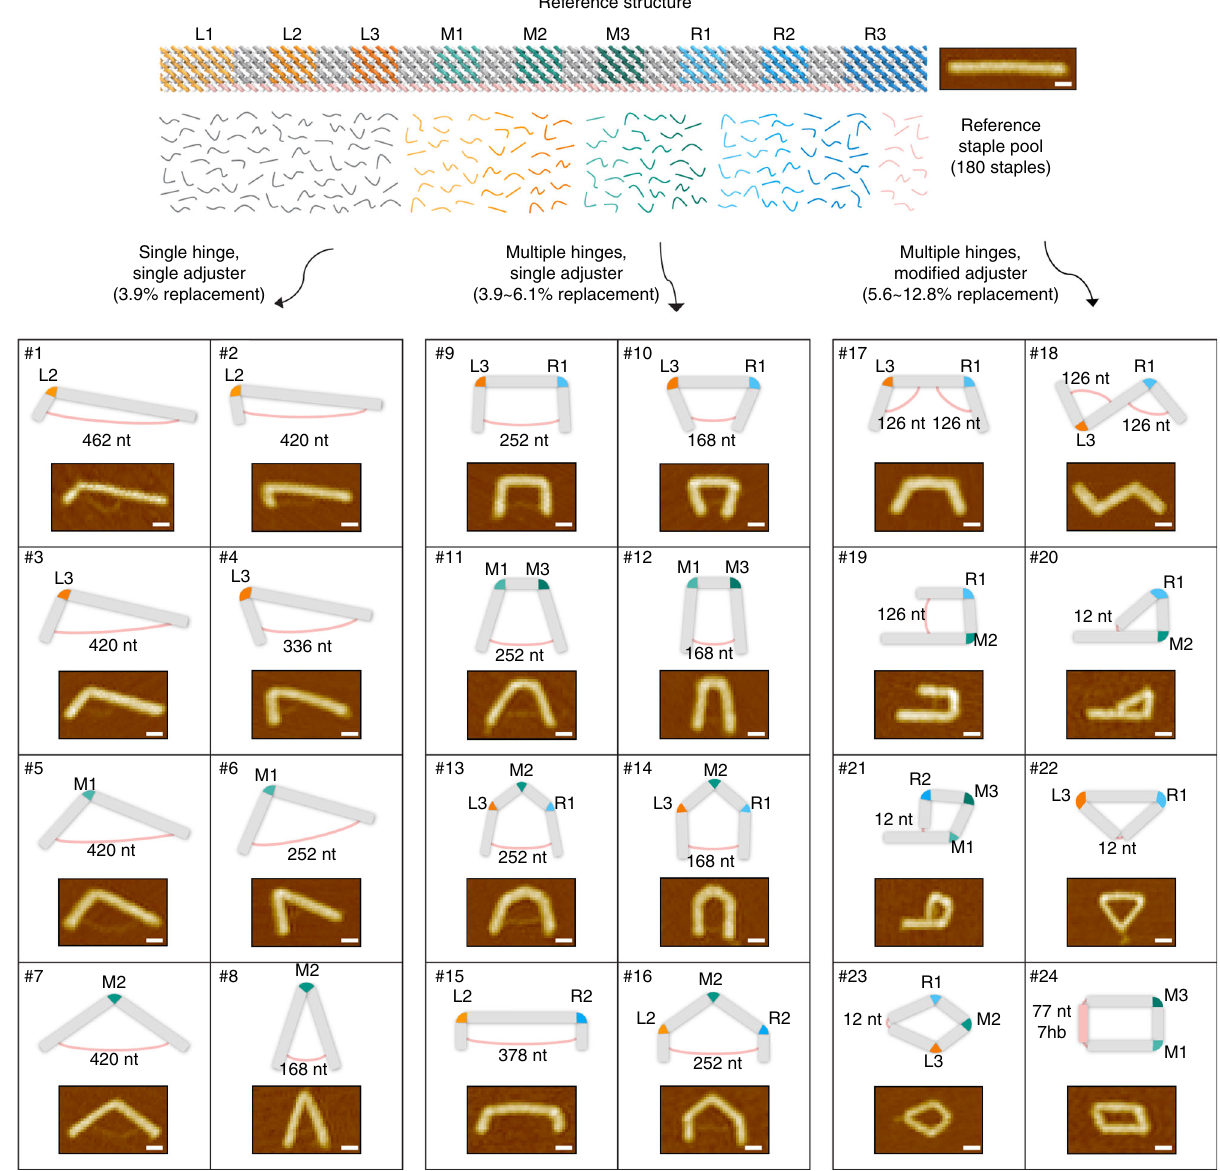
Fig. 2 Demonstration of the 24 structural variations from the straight 12-helix honeycomb-latticed reference structure. The length of each seam region is about 28 nt (~9.5 nm), structural module L1 and R3 are 63 nt (21.4nm), and rest of the structural modules are 35 ~ 42 nt (12 ~ 14.3 nm) long. In total, 180 staples constitute the reference structure consisting of 108 body staples, 60 seam staples, and 12 strut staples. See Supplementary Figs. 6 and 7 for AFM images and detailed layout of the reference structure, Supplementary Figs. 8 – 13 for large-area AFM images of each design variation, and Supplementary Figs. 14 – 16 for CanDo shape prediction. Scale bars: 30 (Fig. 5a). The most fl exible case was a ds0hb hinge, where all 11 structural staples were removed from the M2 module so that only unbound scaffold single strands remained. Stiffer hinges were then devised by adding 2 – 6 hinge staples to it leading to ds2hb, ds3hb, ds4hb, and ds6hb hinge structures, where each number indicates the number of dsDNA helices at the cross- section. Results from agarose gel electrophoresis and AFM ima- ging indicated that stiffening the hinge deteriorated the monomer folding yield and increased the number of aggregated structures (Fig. 5b, c, and Supplementary Fig. 27). Intensity ratios of the monomer band to all bands were 85.8, 79.1, 69.0, 31.1, and 7.0% for ds0hb, ds2hb, ds3hb, ds4hb, and ds6hb hinge, respectively. A drastic drop in the number of monomeric structures were observed for structures with ds4hb hinge and stiffer ones,